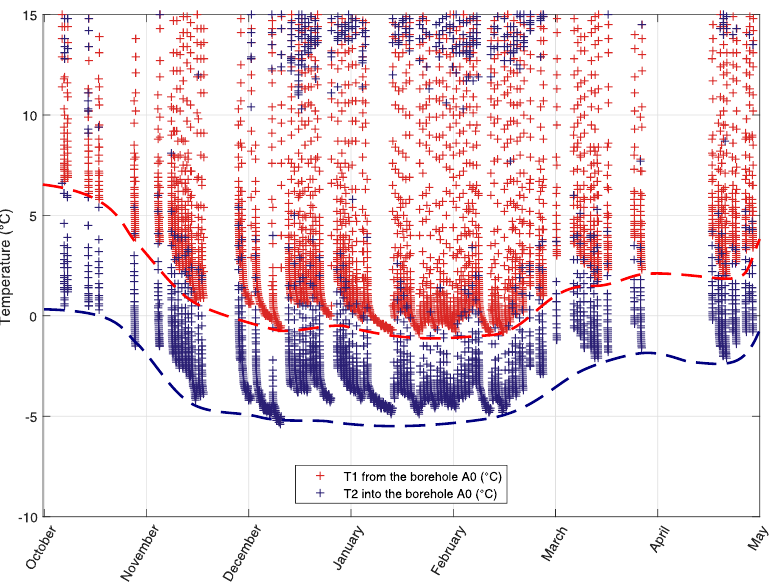
Figure 3. Development of temperature changes in energetically utilized operational borehole A0 during one heating